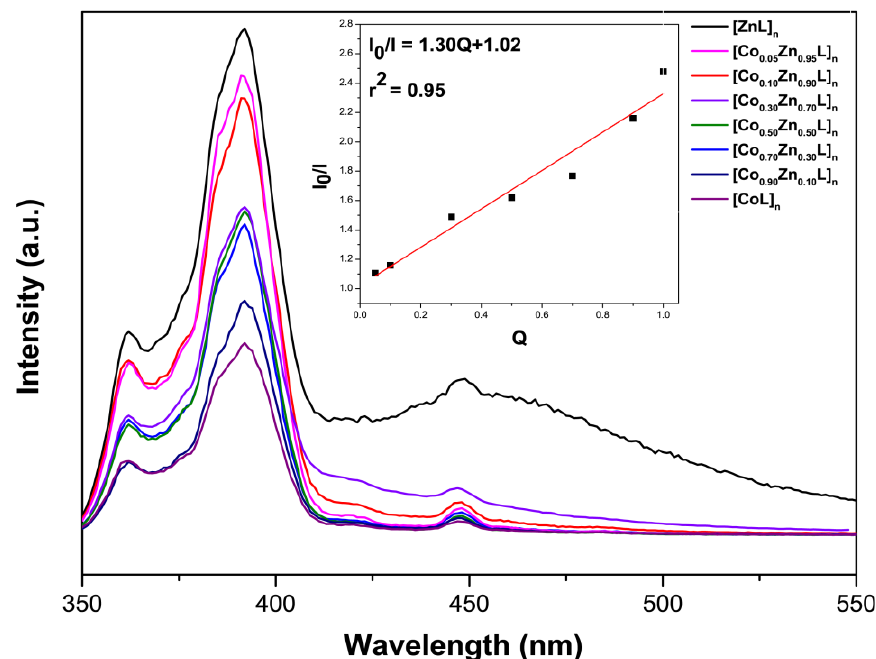
Figure 8. Fluorescence spectra of homometallic Zn II and Co II compounds and [Co x Zn 1-x L] n (where x= 0.9–0.1 stands for the proportion of Zn in the formula) at RT ( λ ex = 330 nm). Inset graph: Stern– Volmer plot with regard to the relative intensity of the main emission band .